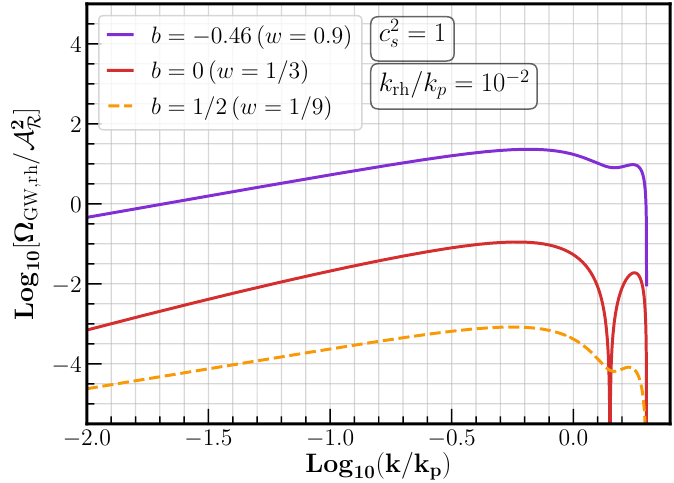
Figure 4. Induced GW spectral density for a Dirac delta primordial spectra, in terms of wavenumber k / k p . This time we chose c 2 s = 1 and, therefore, the resonant peaks of Figure 3 are absent. We show in red w = 1/3, in purple w 0.9 and in orange w = 1/9. We see how the stiffer the w , the larger the ∼ overall amplitude of the induced GW